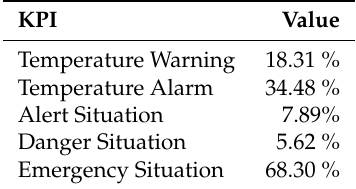
Table 1. KPI results obtained in poultry breeding phase.